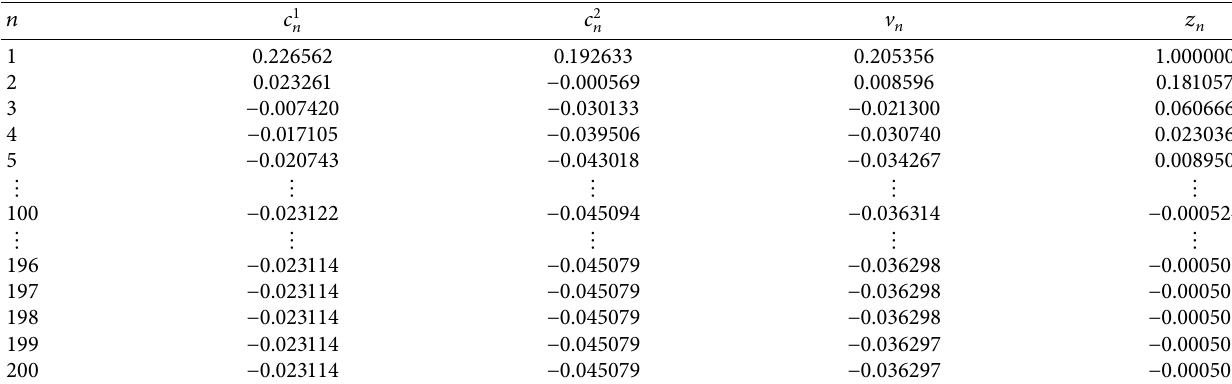
Figure 1: The convergence of all sequences for the iterative method (51) and (95). (a) The iterative method (51) (b) The iterative method (95). Table 2: The values of all sequences for the iterative method